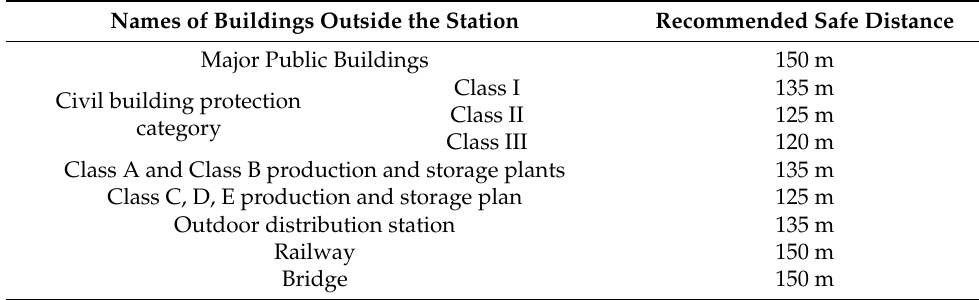
Table 3. The recommended safe distance between shore-based bunkering station for hydrogen powered ships and buildings outside the